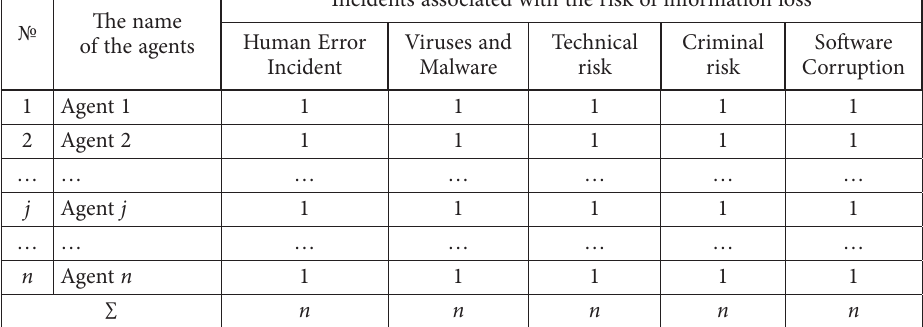
Table 3. The matrix of binary peculiarities for all possible cases of factors’ impact on risk incidents (source: compiled by author) The name № of the